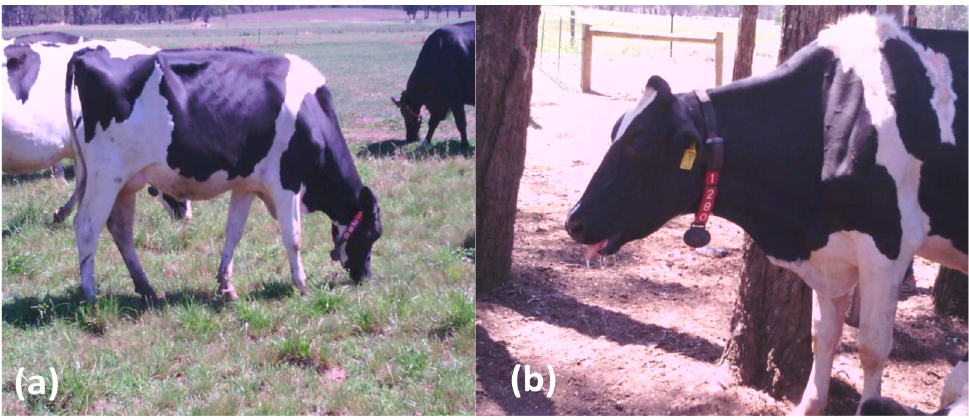
Figure 1. Effect of THI on cow behavior—same cow at THI = 70 ( a ) and THI = 84 ( b ). Highly significant ( p ≤ 0.01) positive correlations were obtained between THI and RR, PS, SBT, milk temperature and protein (Table 4).